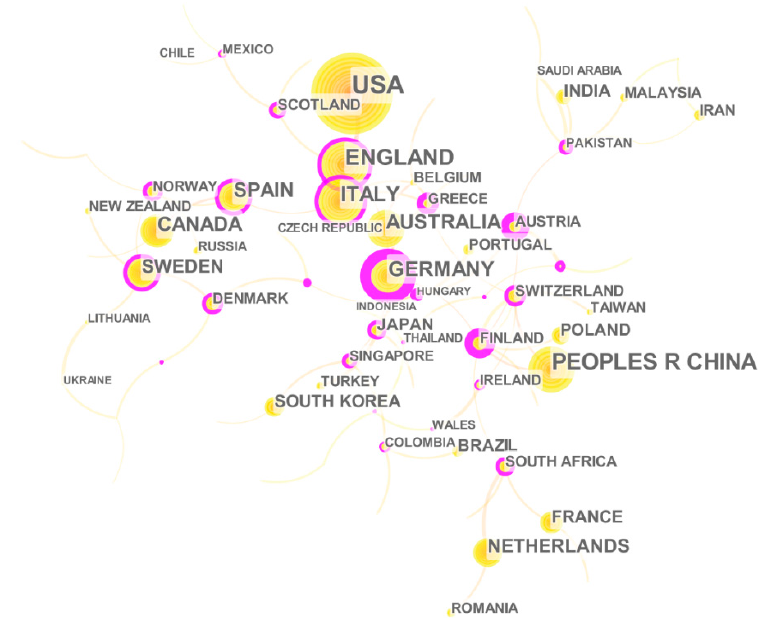
Figure 8. Distribution of main countries.